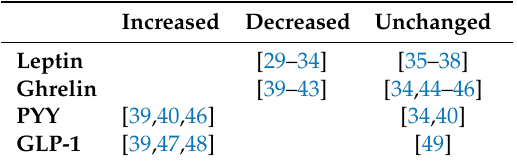
Table 2. Summary of discussed appetite regulating hormones’ response to